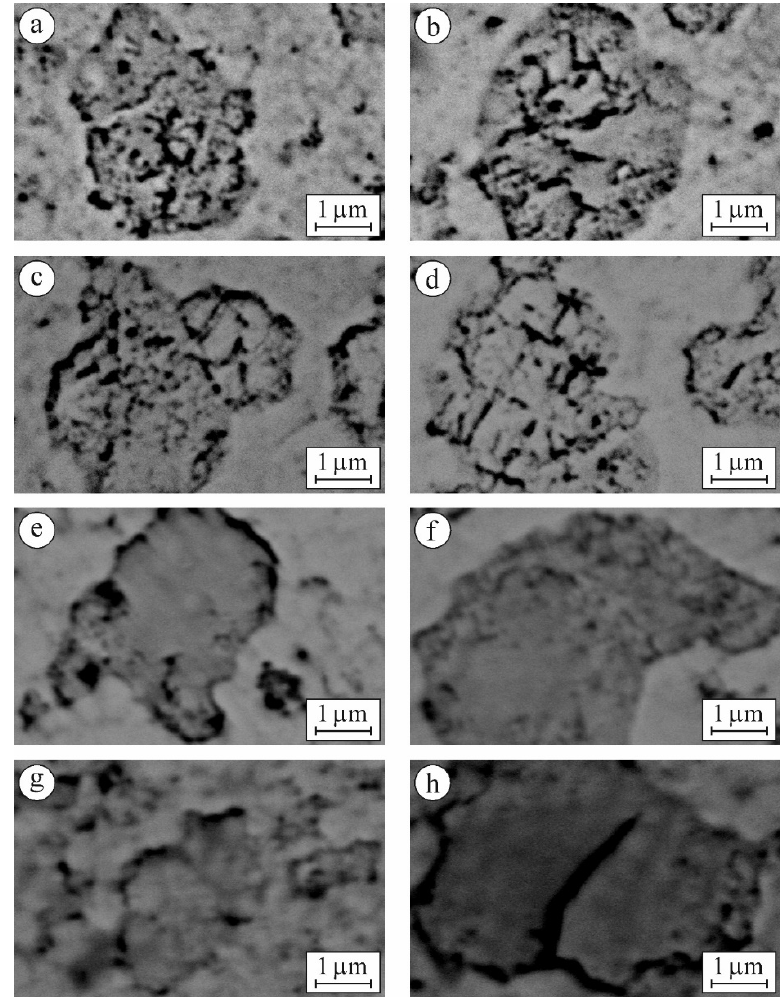
Figure 7. SEM microstructures (BSD images taken at a high magnification) of specimens of ( a ) 6YSZ ‐ 1450, ( b ) 6YSZ ‐ 1500, ( c ) 6YSZ ‐ 1550, ( d ) 6YSZ ‐ 1600, ( e ) 7YSZ ‐ 1550, ( f ) 7YSZ ‐ 1600, ( g ) 8YSZ ‐ 1550, and ( h ) 8YSZ ‐ 1600 ceramics.